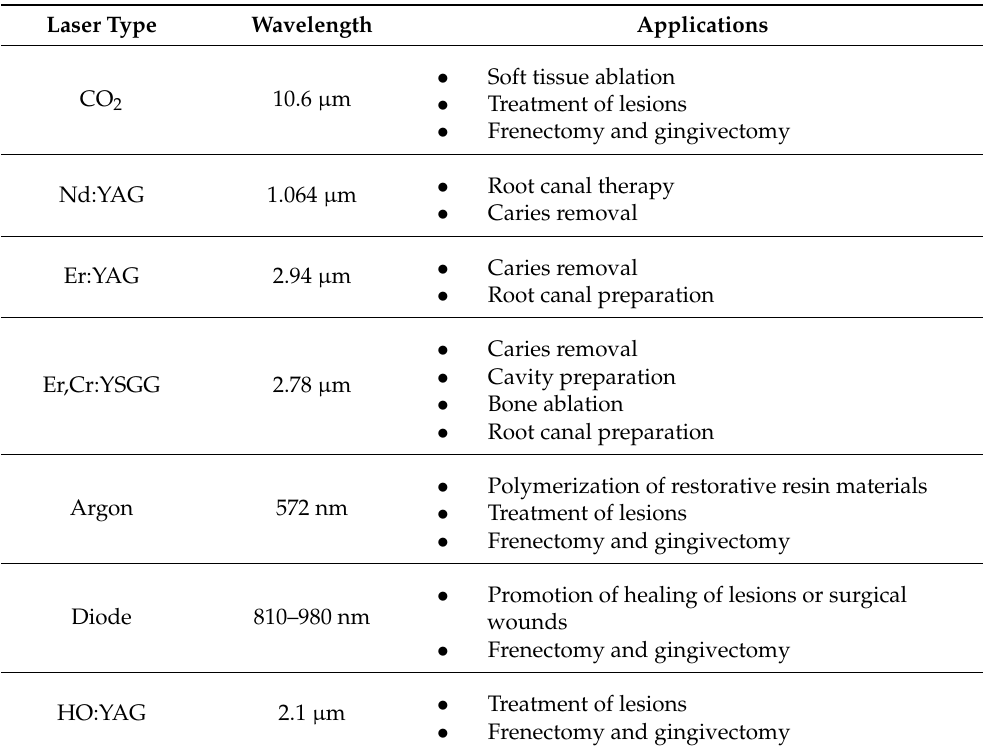
Table 1. Brief summary of commonly used lasers and their applications in dentistry. Adapted with permission from Ref. [82] 2022,